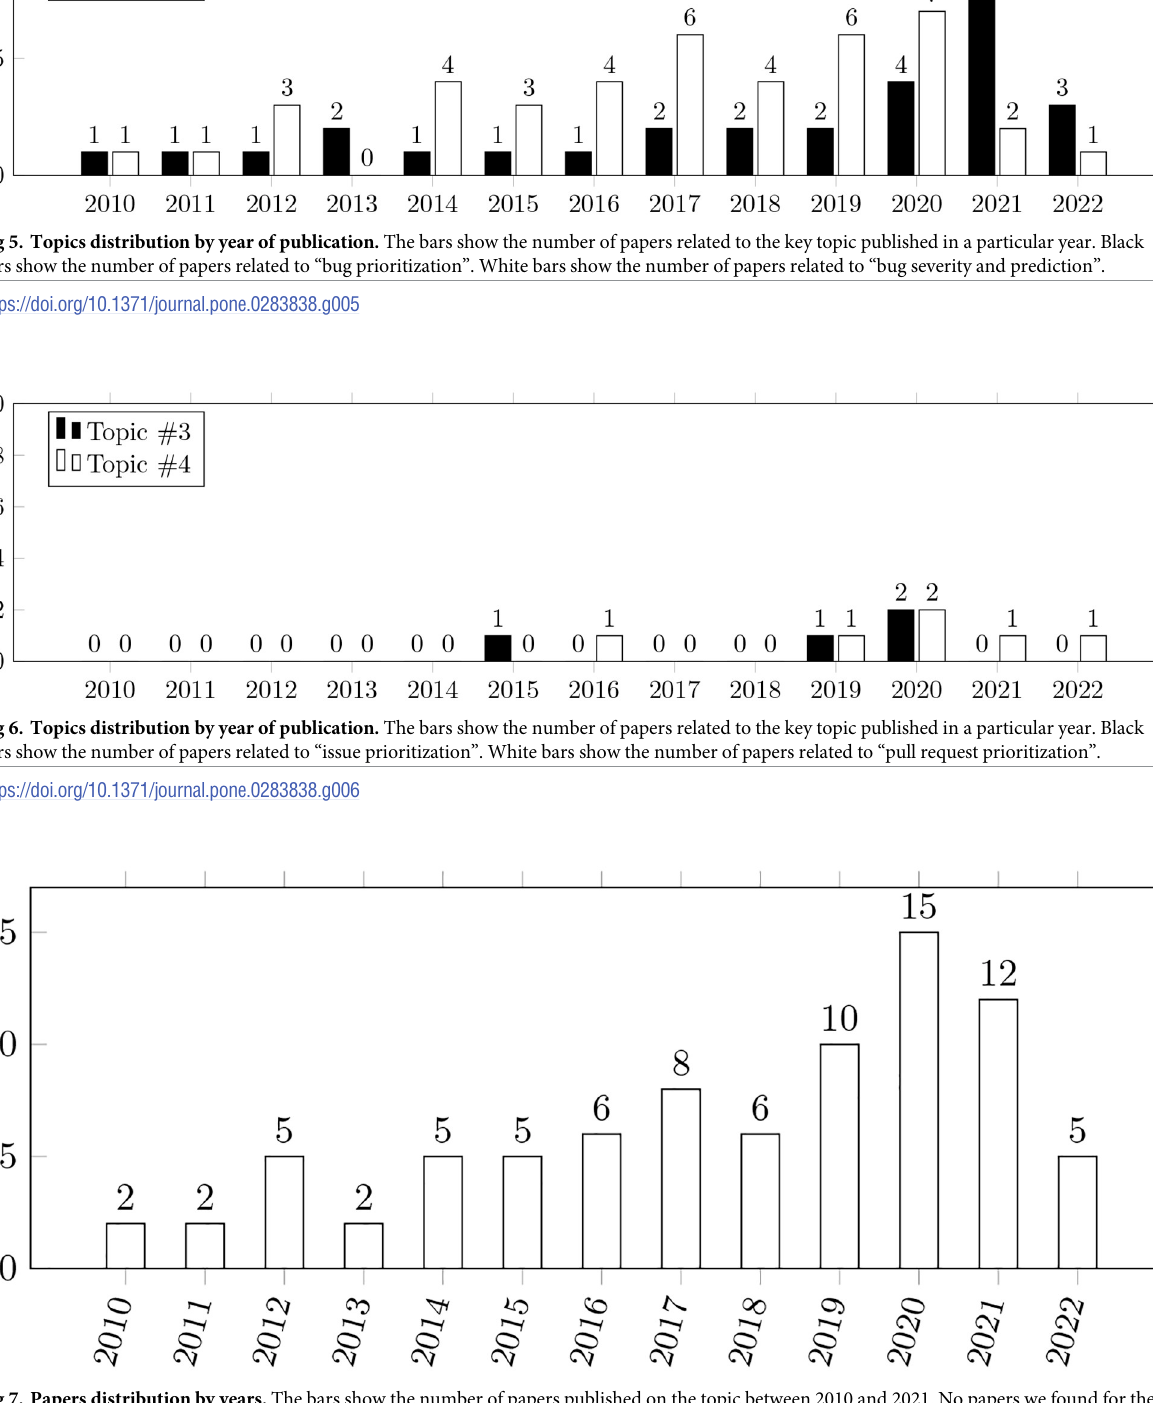
PLOS ONE | https://doi.org/10.1371/journal.pone.0283838 April 6, 2023 13 /